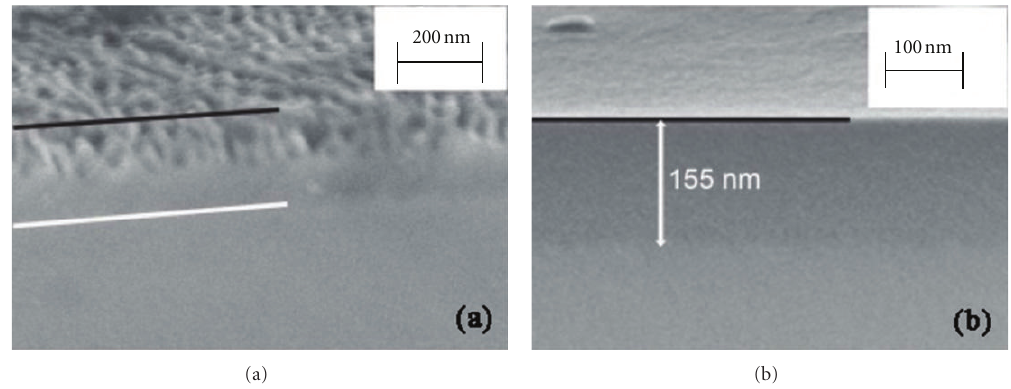
Figure 4: Cross-sectional SEM images of 100 keV 2 × 10 16 Mn ions/cm 2 irradiated Ge surfaces at 170 ◦ C (a) and LN substrate temperature (b). Black lines in the images are drawn to mark the edge between the Ge upper surface and the cross-sectional wall, while white lines mark the depth of implanted layer. Reproduced from [13]. Copyright ©2011, American Physical Society.